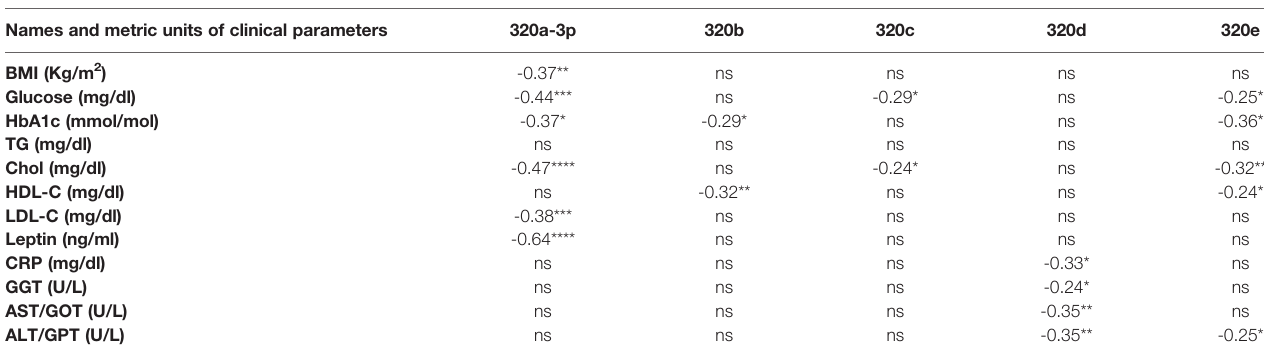
TABLE 2 | Results of correlation analysis for clinical parameters with relative levels of cmiRs-320. Names and metric units of clinical